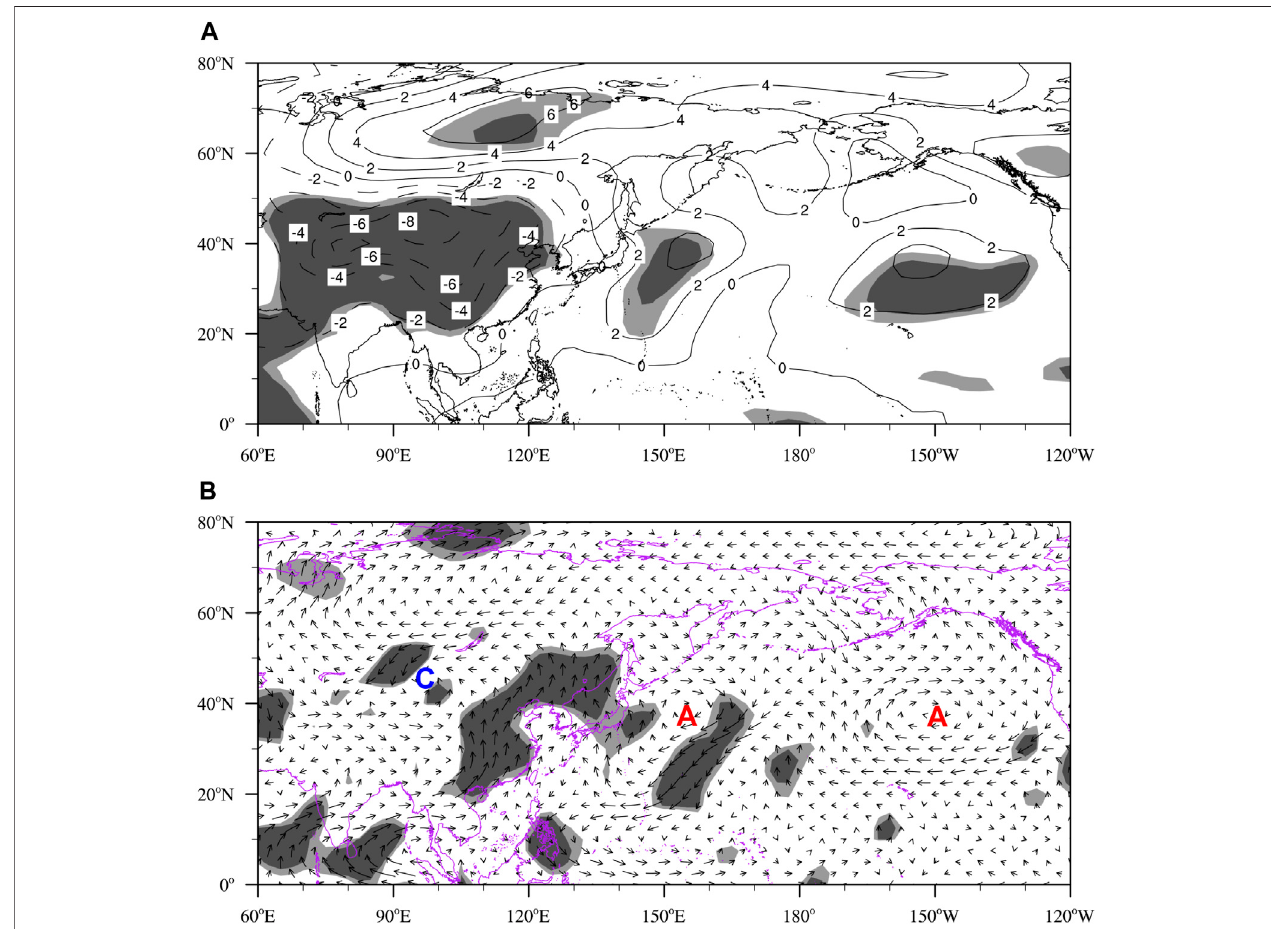
FIGURE 8 | Regressed September 850 hPa (A) H ’ (unit: m; contours) and (B) wind fi eld (unit: m s − 1 ; vectors) onto the APOI for 1961 – 2020. Dark (light) shadows represent the 95% (90%) con fi dence level. Anomalous cyclones and anticyclones are marked with blue ″ C ″ and red ″ A, ″ respectively.